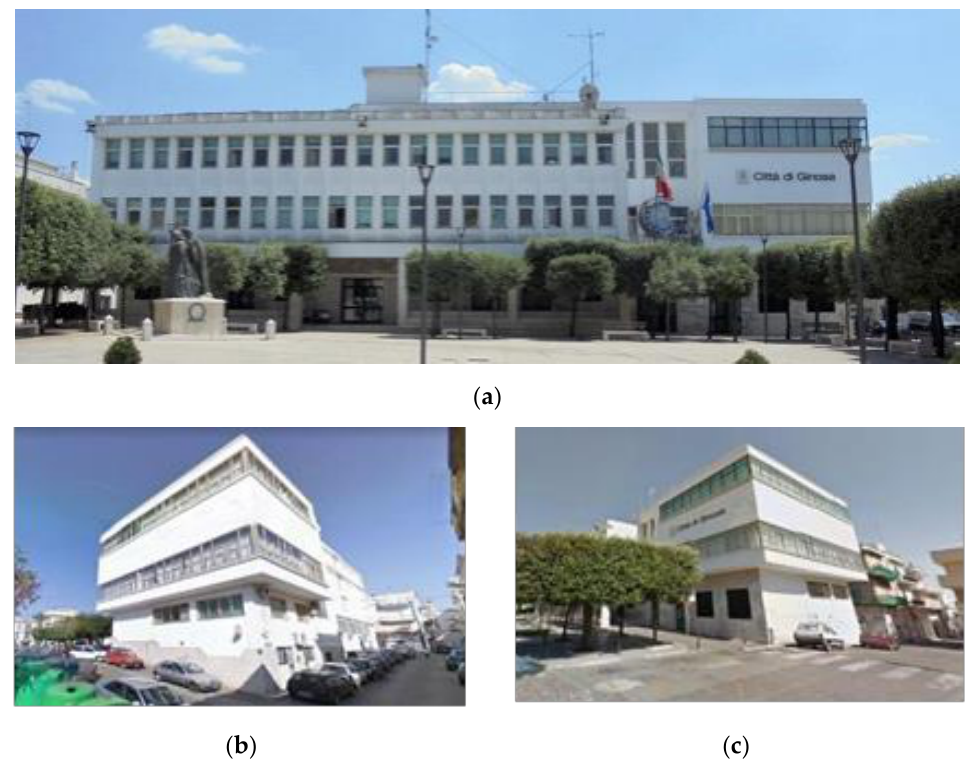
Figure 2. ( a ) North view of the City Hall building; ( b ) northwest view of the City Hall building; ( c ) southwest view of the City Hall building—Structure B.